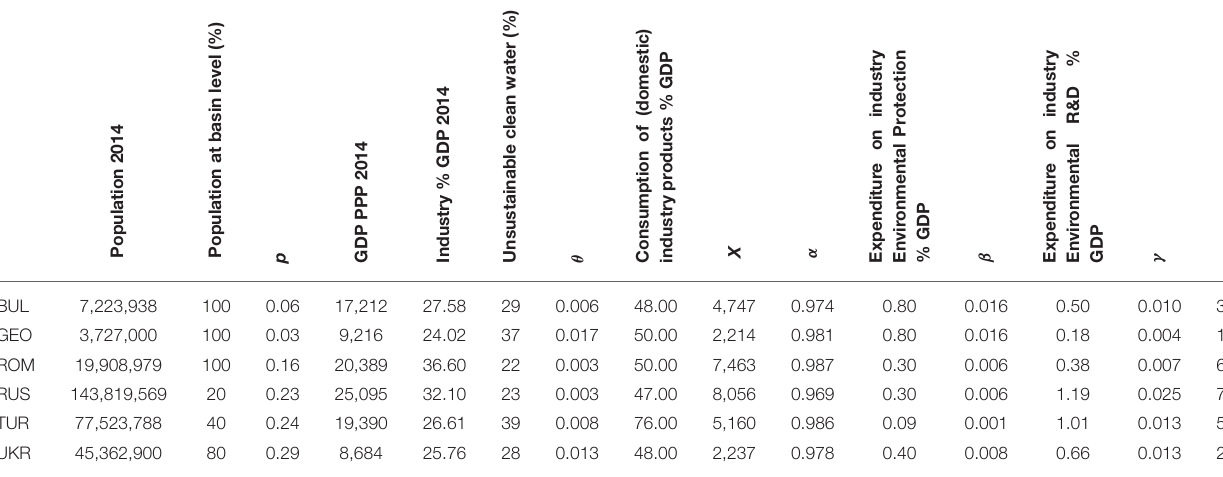
2014 n o i a t u l op P